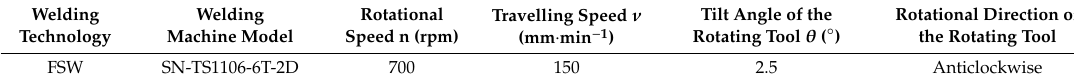
Table 3. Welding parameters of FSW